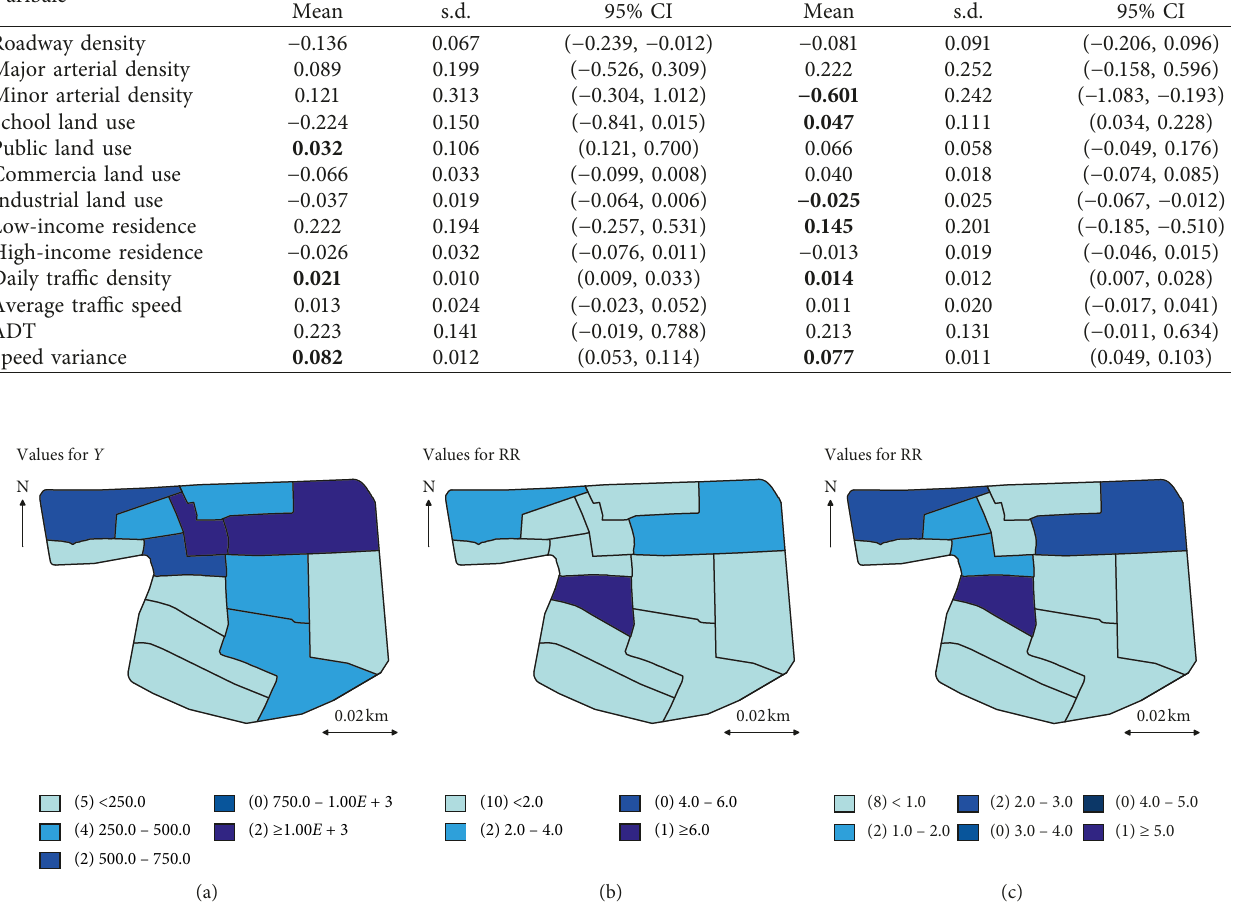
Figure 4: Crash count, relative risk of intrinsic and Cressie model estimation. (a) Crash Count. (b) Intrinsic model estimation. (c) Cressie model estimation. Table 3: Bayesian modeling results of CT and TAZ